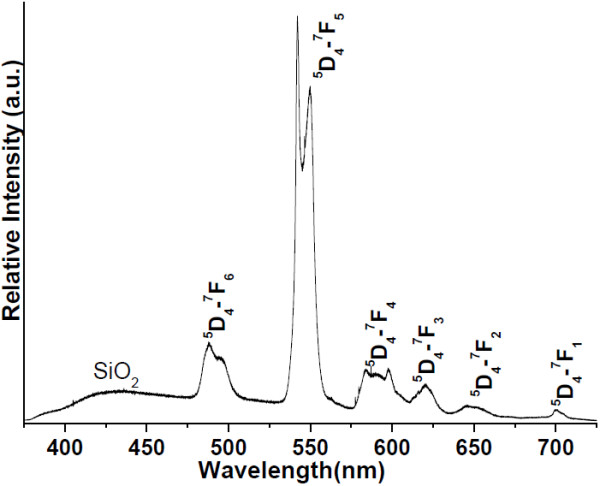
Photoluminescence spectrum of luminescent mesoporous Tb(OH)3@SiO2core-shell nanospheres.